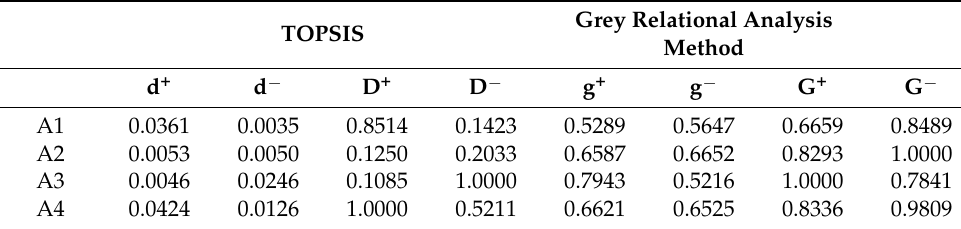
Table 7. Euclidean distance and grey correlation degree for choosing a third-party logistics provider